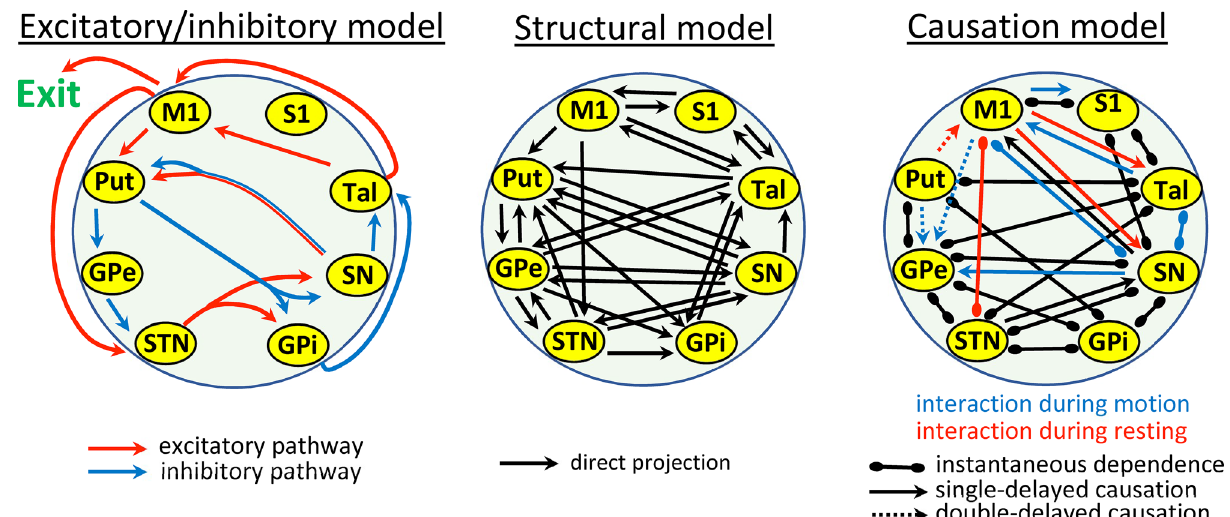
Figure 4. Basal ganglia models. The classical basal ganglia model (left-side) is mainly based on the excitatory (red) and inhibitory (blue) interactions of the BG centers involved in the direct, indirect and hyperdirect pathways of the cortico-subcortical loops. The structural model shows most of the BG pathways, also including those involved in subcortical loops. The causation model (right-side) includes all the instantaneous (lines) and delayed (arrows) interactions observed during resting (blue), motion (red) and both resting + motion (black). M1: primary motor cortex, S1: primary somato-sensory cortex, Put: putamen, GPe: external globus pallidum, STN: subthalamic nucleus, GPi: internal globus pallidum, SN: substantia nigra, Tal: motor